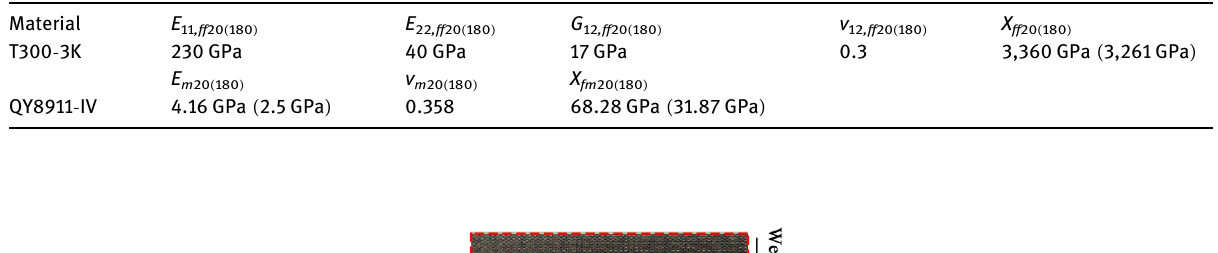
Table 1: Mechanical properties of T300 - 3K and QY8911 - IV at 20°C and 180°C [ 28 ]